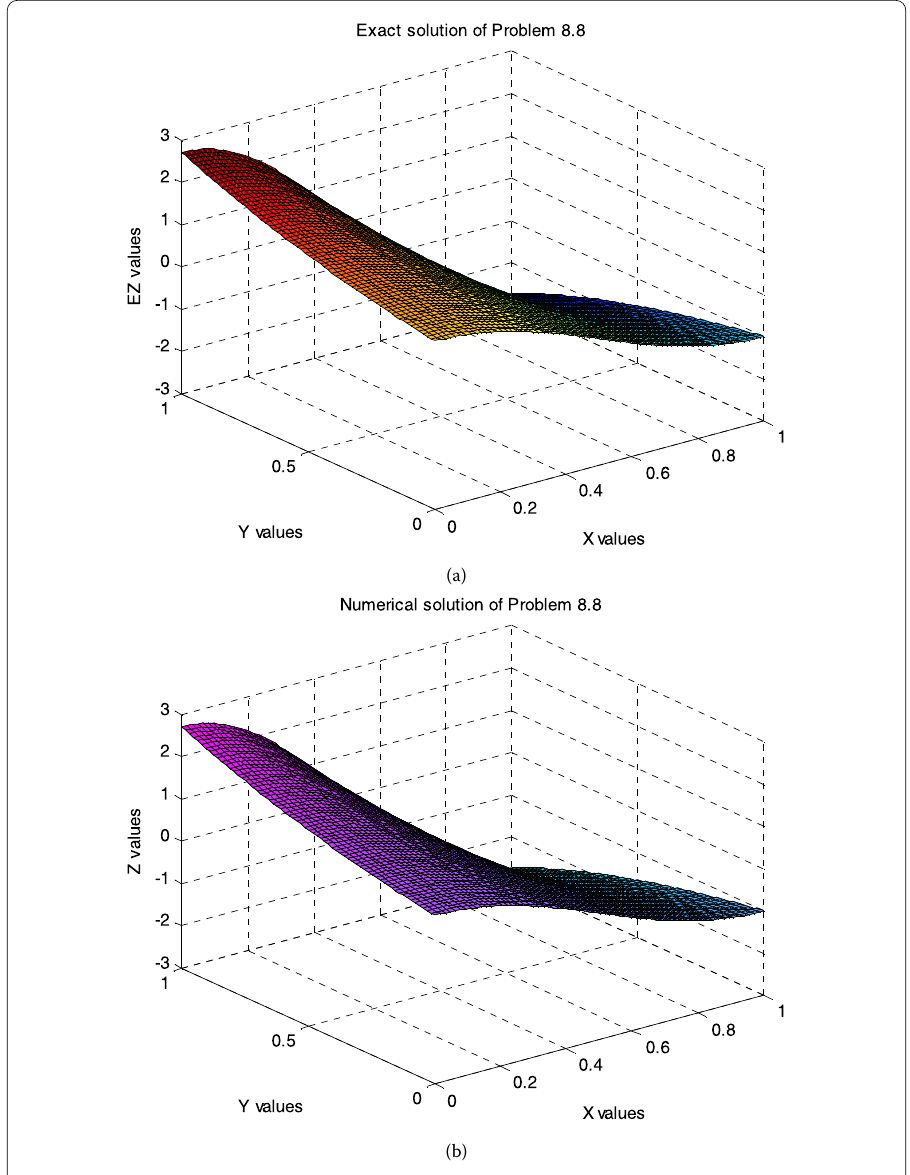
Figure 9 ( a ) Exact solution of Problem 8.8 for h = 1/32 and Re = 10. ( b ) Numerical solution of Problem 8.8 for h = 1/64 and α = 1